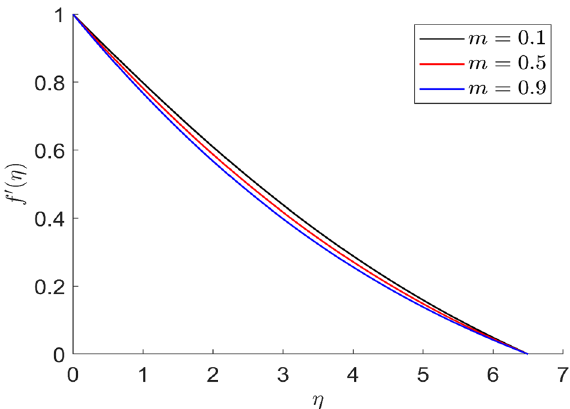
Figure 7. Representation of radial velocity f ′ (η) for the different values of m with R = 3, n = 3, v = 0.1, φ = 0.2, Pr = 0.6, φ 1 = 0.4, φ 2 = 0.8, β 3 = 0.5, β = 0.4, β 1 = 0.5, β 2 = 0.9, u = 0.2, ξ = 0.2.